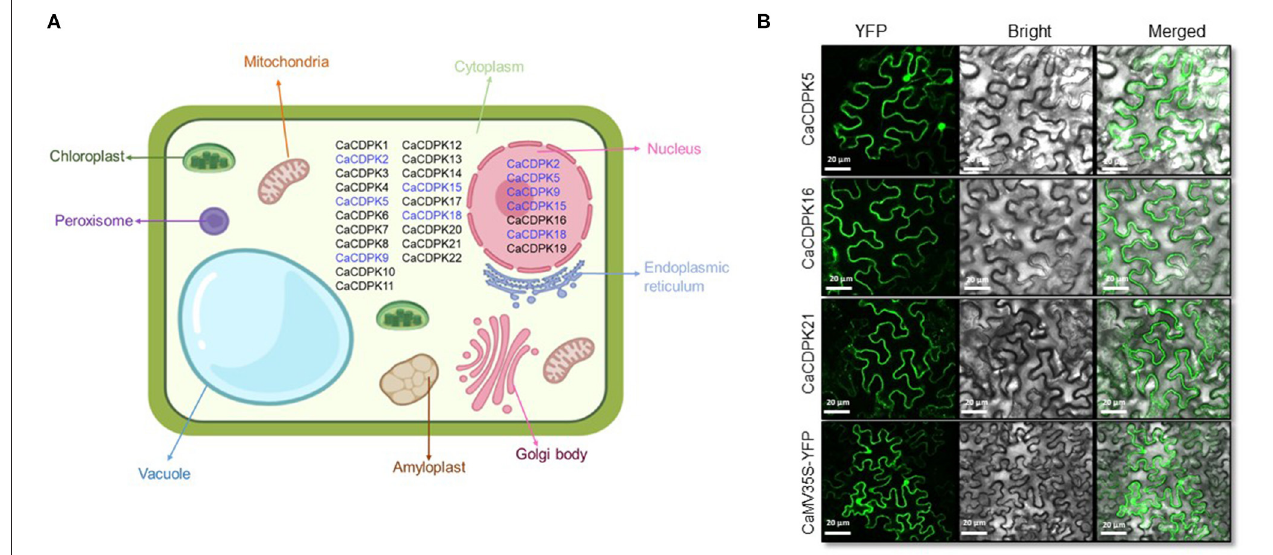
FIGURE 5 | Subcellular localization of chickpea CDPK proteins. (A) Localization was predicted using an online tool, CELLO. The figure shows chickpea CDPK proteins localized majorly in the cytoplasm and nucleus based on the highest reliability score with black color. Proteins that were predicted to be localized both in the cytoplasm and nucleus are shown by blue color at both locations. (B) N. benthamiana cells expressing the YFP- fusion protein driven by the 2XCaMV 35S promoter. Confocal images of fluorescence expressing CaCDPK proteins are showing their variable distribution in different compartments. CaCDPK5 is localized to the cytoplasm and nucleus, whereas CaCDPK16 and CaCDPK21 are localized at the cytoplasm. Cells transformed with vector only (CaMV35S-YFP) are shown in the lowermost row. Scale bar = 20 µ